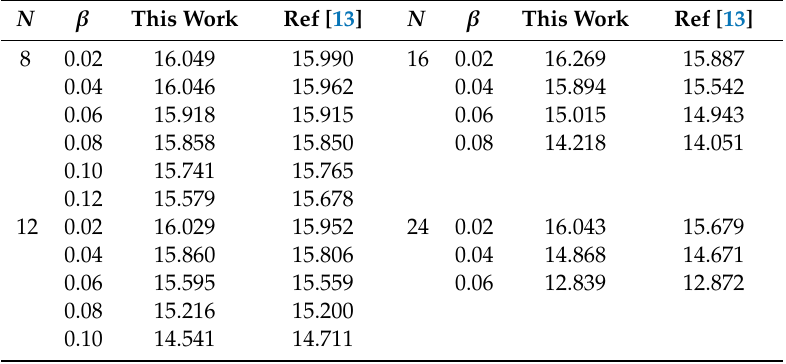
Table 2. Values for Poiseuille number, ( fRe ) , for a di ff erent number of corrugations.